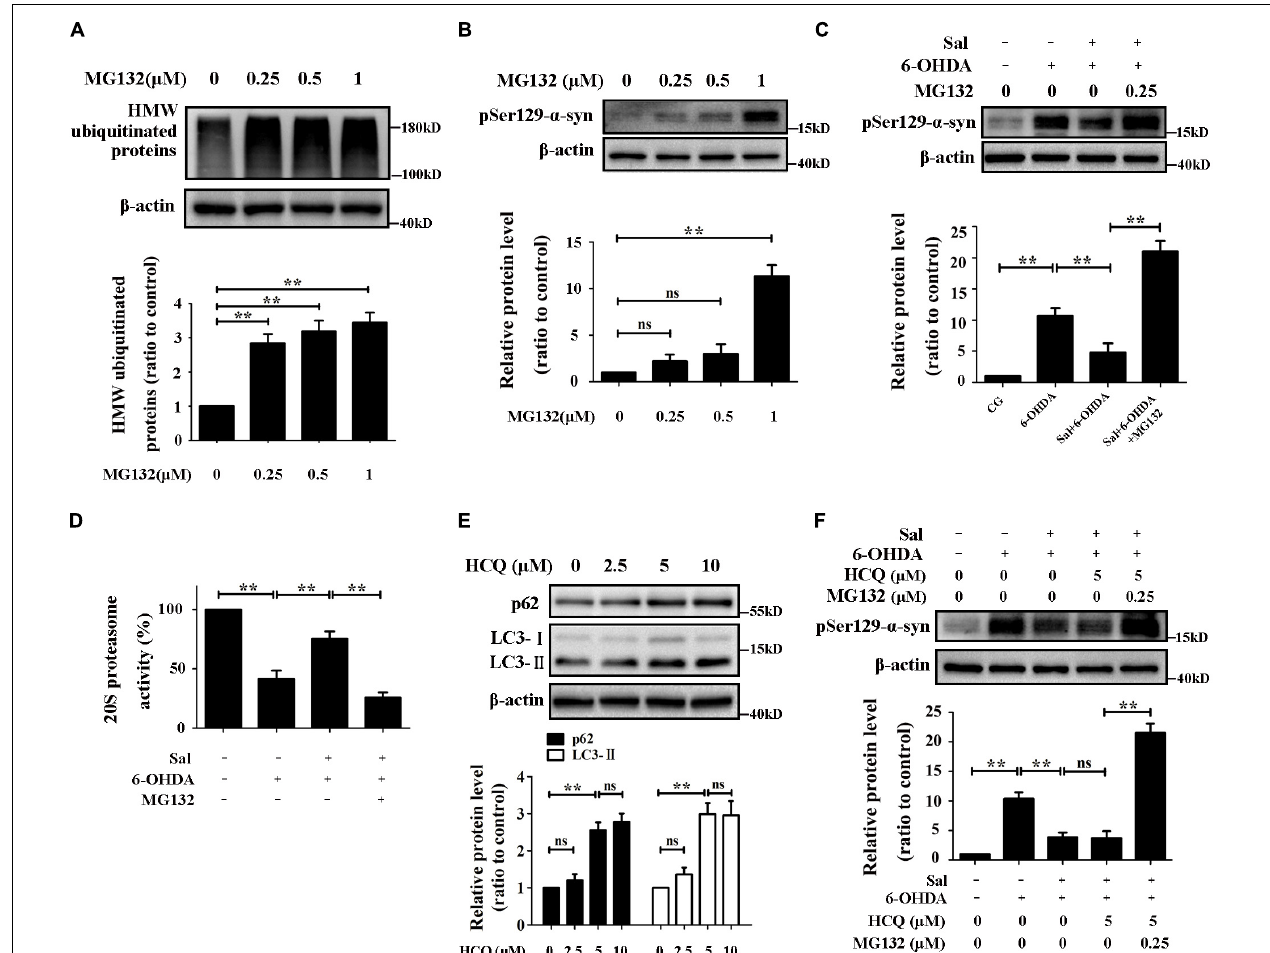
FIGURE 4 | Sal decreased pSer129- α -syn protein level mainly through UPS in SH-SY5Y cells. (A,B) Immunoblot levels of HMW-ubiquitinated proteins and pSer129- α -syn after inhibited the UPS by various concentrations of MG132 (0.25, 0.5, and 1 µ M) in SH-SY5Y cells. (C) Western blot analysis of pSer129- α -syn and PLK2 protein levels in SH-SY5Y cells. Cells were preincubated with Sal (40 µ M) for 24 h, then exposed to 6-OHDA another 24 h in the presence or absence of MG132. (D) Proteasome activity assay analysis of 20S proteasome activity. Cells were preincubated with Sal (40 µ M) for 24 h, then exposed to 6-OHDA another 24 h in the presence or absence of MG132. (E) The p62 (a selective substrate of macroautophagy) and LC3-II (autophagosome marker) protein levels were analyzed by Western blotting. Cells were incubated with HCQ (autophagy inhibitor) for 24 h. (F) Immunoblot level of pSer129- α -syn in SH-SY5Y cells. Cells were preincubated with Sal (40 µ M) for 24 h, then exposed to 6-OHDA for another 24 h in the presence or absence of HCQ, HCQ, and MG132 in SH-SY5Y cells. Data are shown as the mean ± SEM. Statistical significance was analyzed by one-way analysis of variance (ANOVA). A two-tailed Student’s t -test was performed for comparisons between two groups. Each experiment was repeated three times independently. ∗ P < 0.05; ∗∗ P < 0.01, ns: no